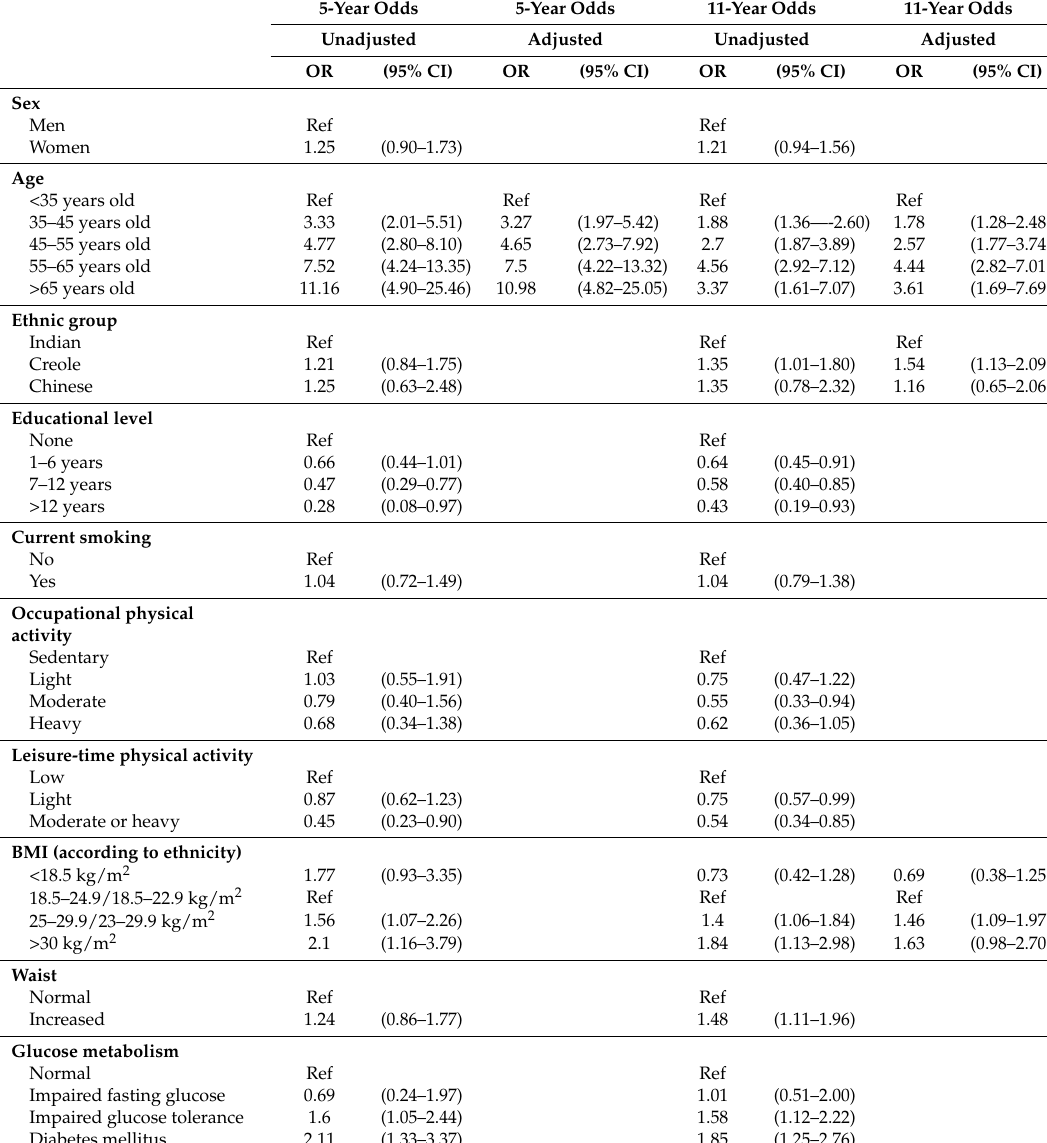
Table 3. Predictors of 5- and 11-year risk of hypertension in prehypertensive people at baseline in Mauritius in